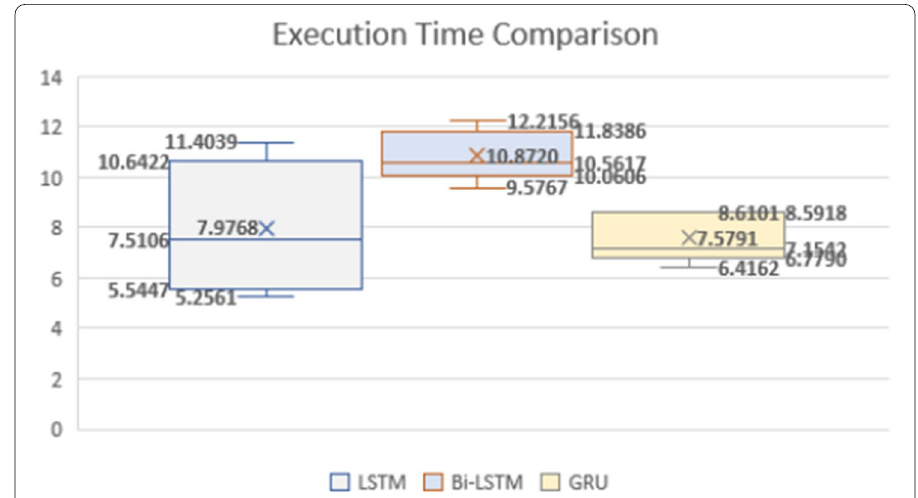
Fig. 9 Execution time comparison of each RNNs deep learning method